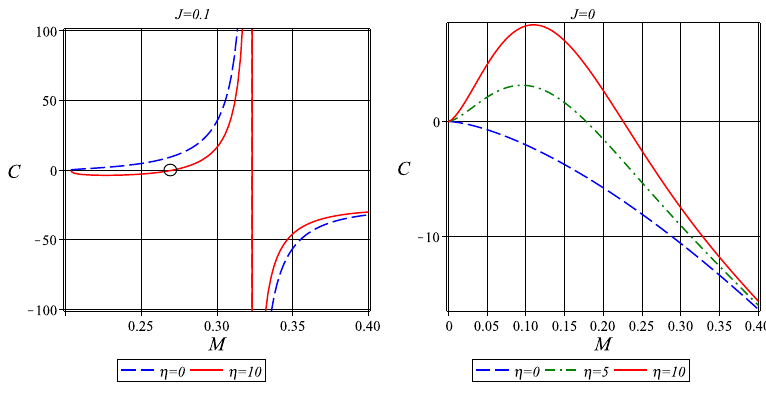
Figure 4 . Specific heat of the Myers-Perry black hole in terms of